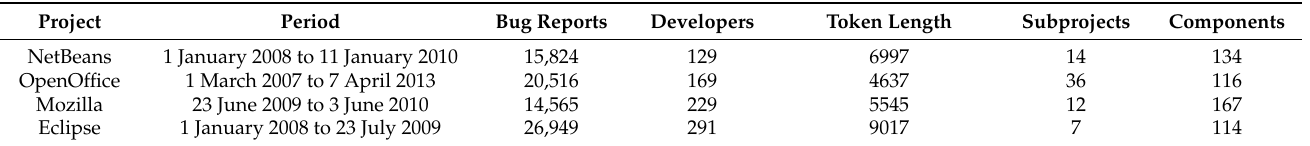
Table 2. Raw datasets for NetBeans, OpenOffice, Mozilla, and Eclipse. Project